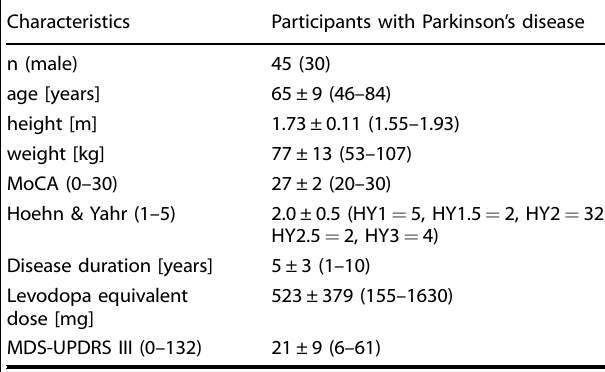
Table 1. Demographics and disease characteristics (mean ± standard deviation (range)) of the participants.